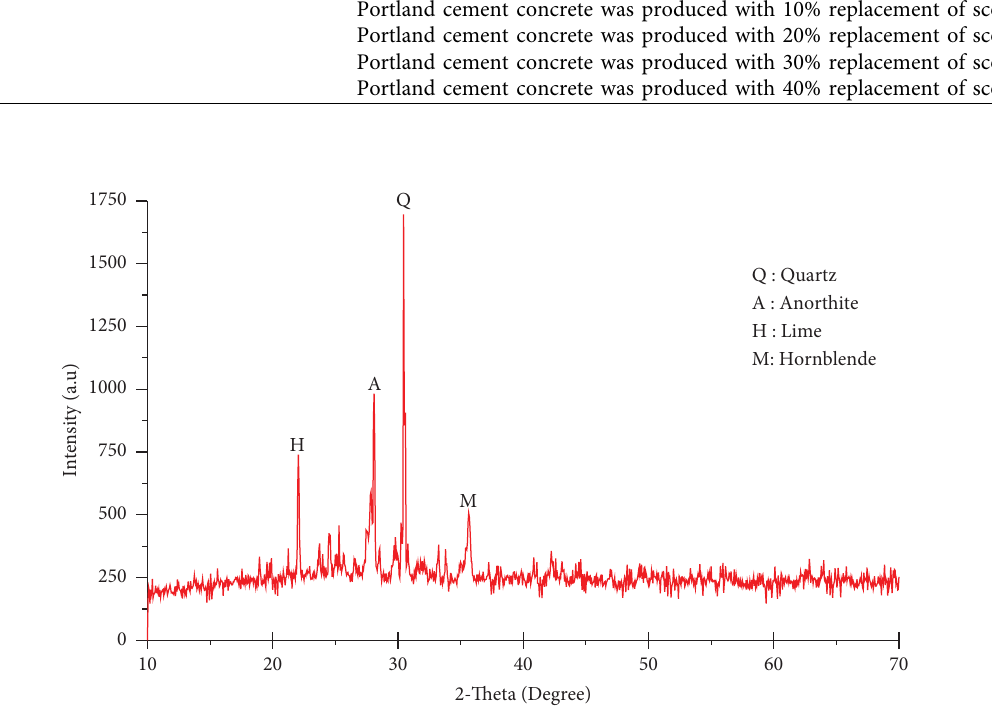
Figure 4: XRD patterns of scoria powder. Table 7: Setting times of blended pastes at various scoria powder